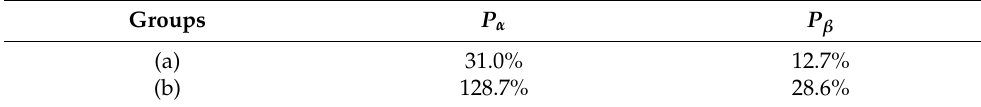
Table 10. Calculation results of the accuracy parameters of Figure 10.